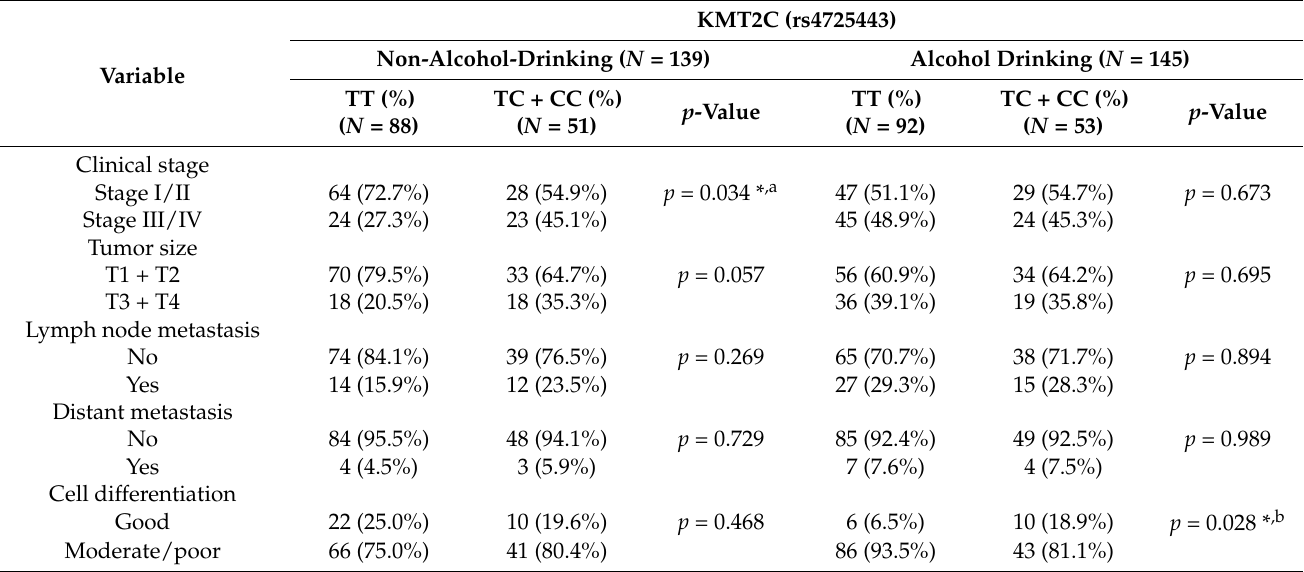
Table 4. Clinical statuses and KMT2C rs4725443 genotype frequencies in cases-of-OSCC group among 139 non-alcohol-drinking and 145 alcohol-drinking cases.